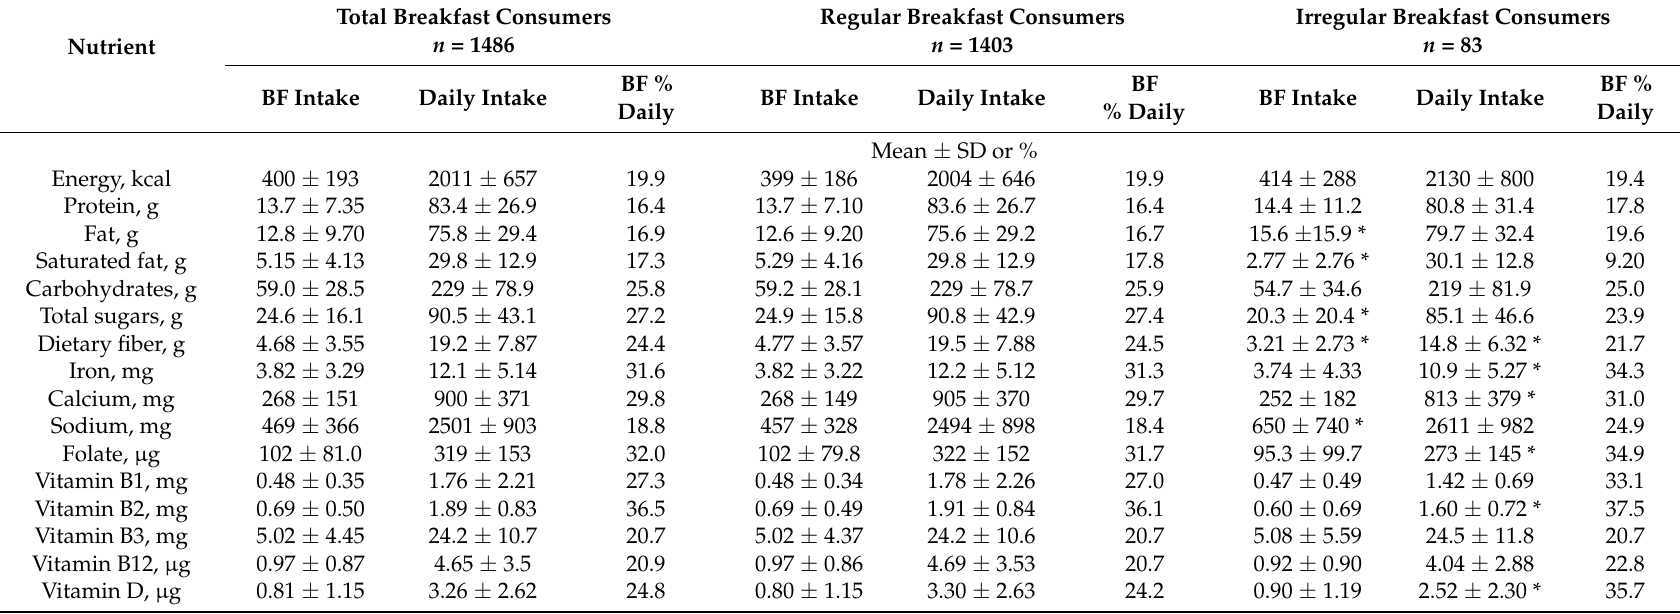
Table 2. Mean daily intakes of energy, macronutrients and micronutrients, at breakfast and overall, among breakfast consumers ( n = 1486) from a national dietary survey of Irish